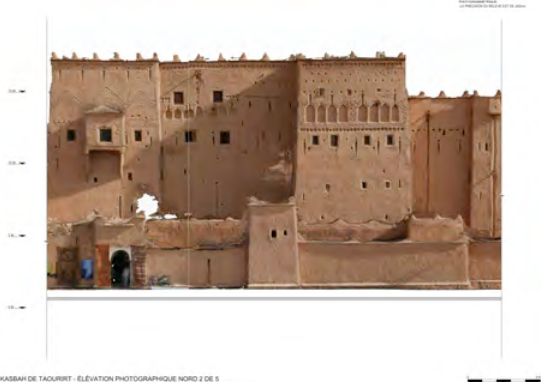
Figure 8: resulting photo elevation with an orthographic image and CAD